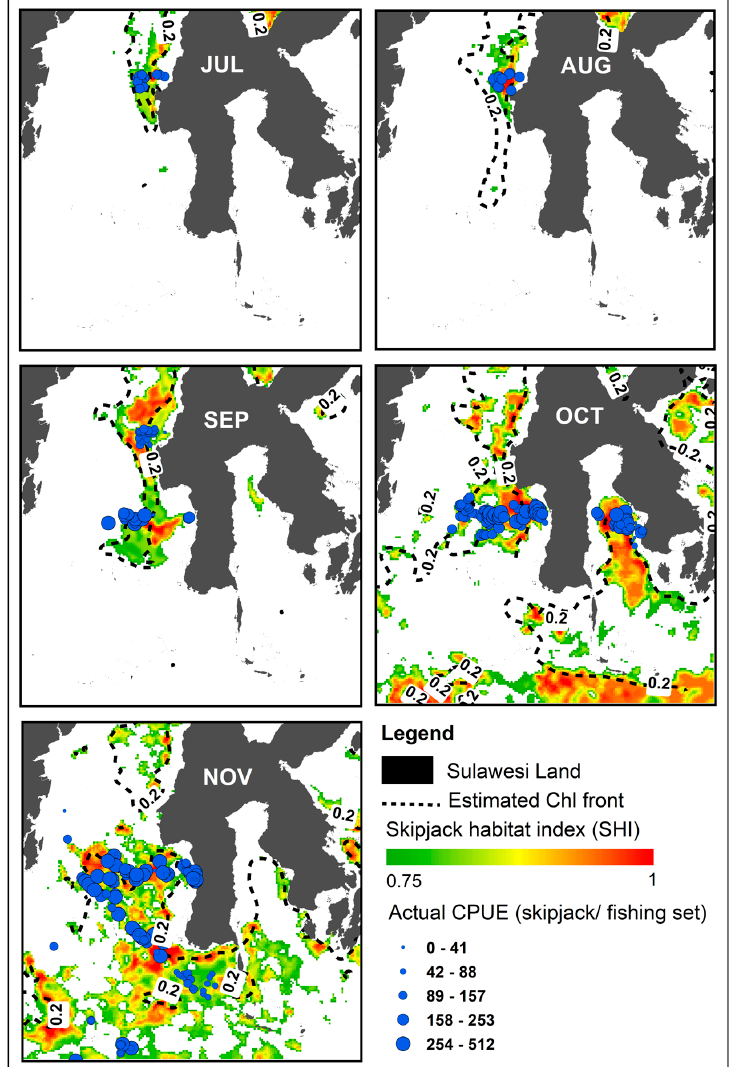
Figure 10. Skipjack CPUE (fish/fishing set) spatial distribution pattern (shown as dots) for July– November 2017 overlain with habitat hotspots and a 0.2 mg m − 3 surface chlorophyll concentration.